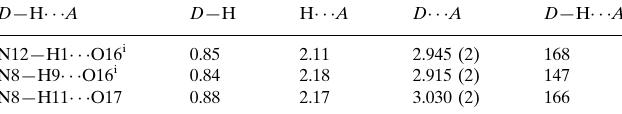
Hydrogen-bond geometry (A˚ , (cid:2)